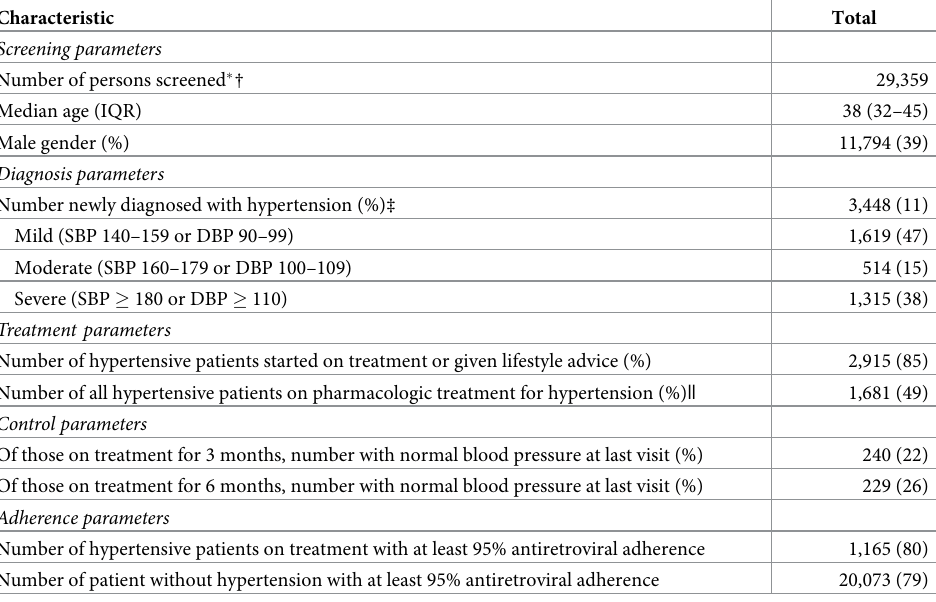
Table 3. Postimplementation program evaluation data for 2 Lighthouse Trust pilot sites in Lilongwe, Malawi, February 2015 to June 2016.